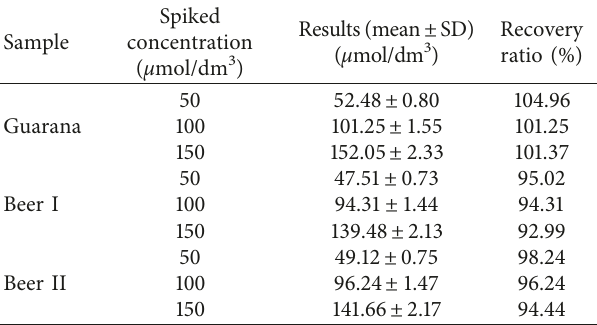
Table 4: Analysis results of the recovery for spiked samples ( n � 3).